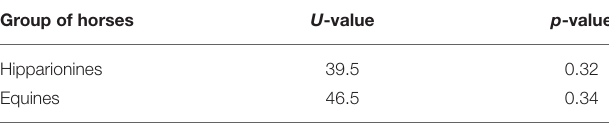
TABLE 3 | Results of the Mann-Whitney U -Tests ( p < 0.05) of the temporal duration of the Mexican and North American hipparionines and equines. Group of